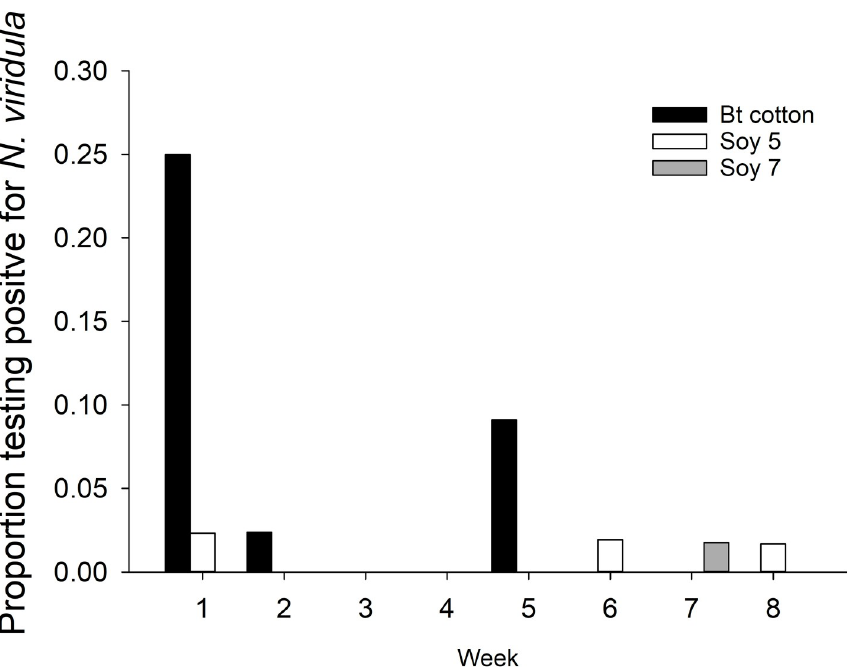
Fig 3. 2011 Gut content results by crop. Proportion of combined predators testing positive for N . viridula DNA by crop and sampling week, 29 July– 7 October 2011. Predators are Coleomegilla maculata , Geocoris spp ., Orius spp ., Notoxus monodon , Nabis spp ., and Oxyopes spp .